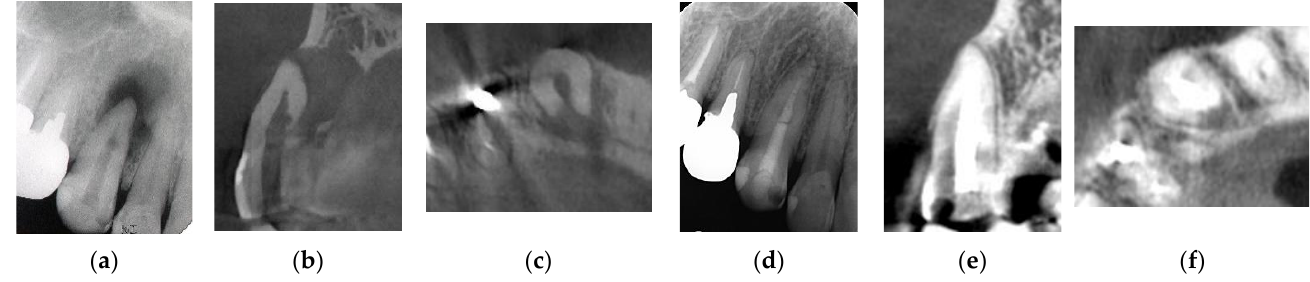
Figure 2. Clinical case 1. Male, age 43 yrs. ( a ) Preoperative periapical radiograph of the right maxillary canine, with the “bone” defect presenting as a radiolucent area in both the middle of the root and the apical lesion. ( b , c ) Preoperative CBCT showing a radiolucent lesion on the periapical and palatal areas. This patient underwent endodontic treatment with MTA under microscopy. ( d ) Follow-up periapical radiograph 4 years later. ( e , f ) Follow-up CBCT 4 years later, showing filling of the root canal and healing.